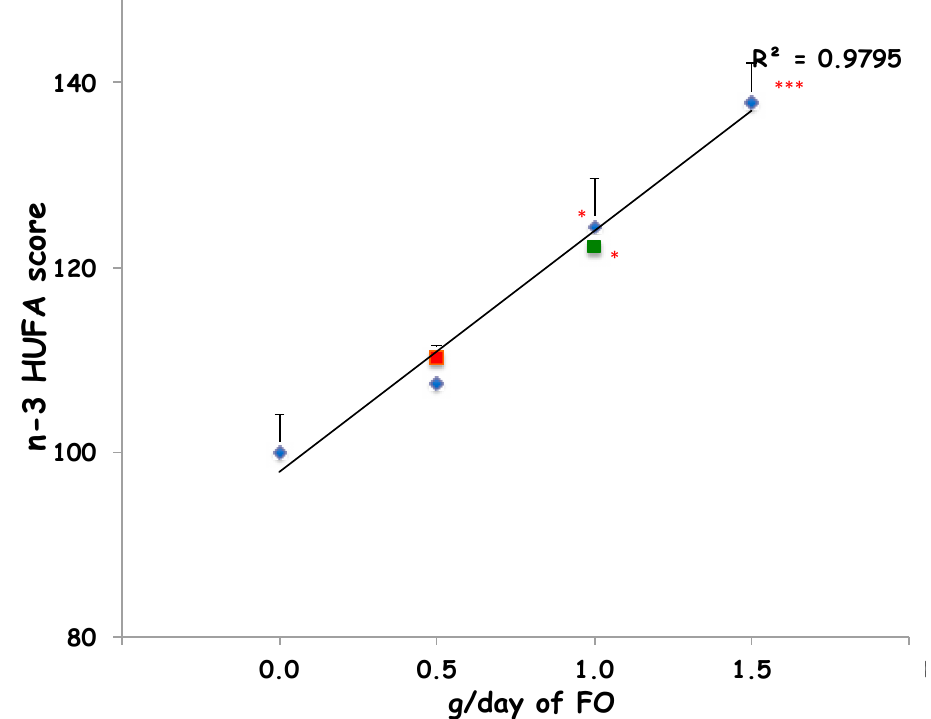
Figure 1. Plasma n-3 highly unsaturated fatty acids (HUFA) scores of subjects fed with 0.0, 0.5, 1.0, and 1.5 g/day of fish oil (FO) ( ◆ blue diamond) or 90 g/day of sheep-1-ENCH cheese for two weeks ( ■ red squares) and four weeks ( ■ green squares). The data are expressed as mean ± SEM per group; * p < 0.05; *** p < 0.001 versus baseline (time 0).